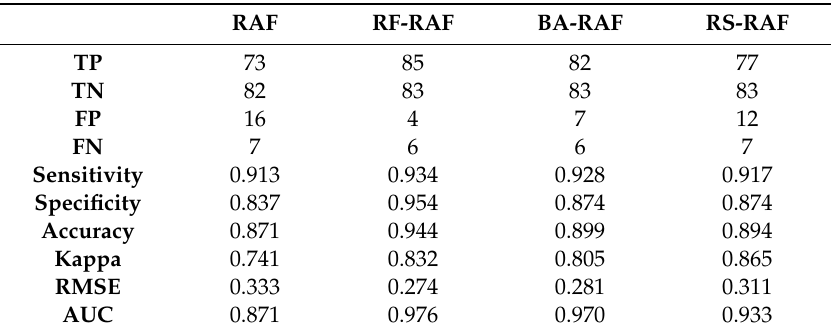
Table 3. Model performance (goodness-of-fit) for the training